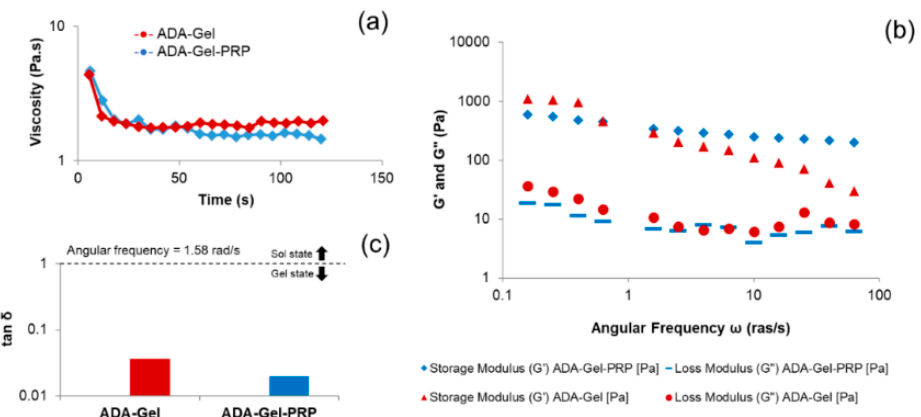
Figure 4. Rheological properties of ADA–Gel–PRP hydrogel: ( a ) viscosity plot, ( b ) storage and loss modulus plot, and ( c ) tan δ data show shear-thinning properties and stiffness of ADA–Gel–PRP bioink formulation.